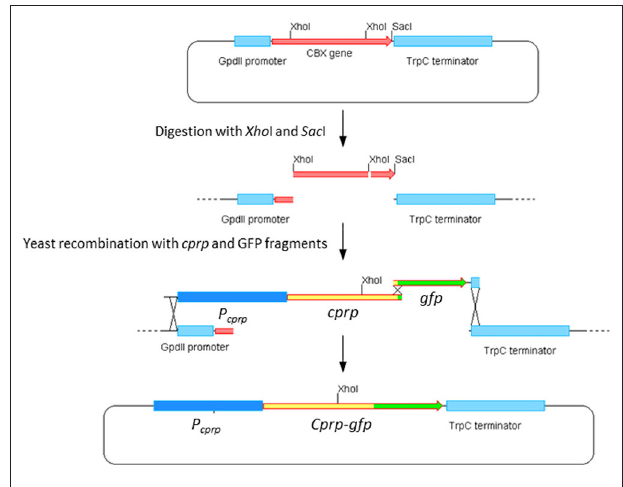
FIGURE 7 | Construction of